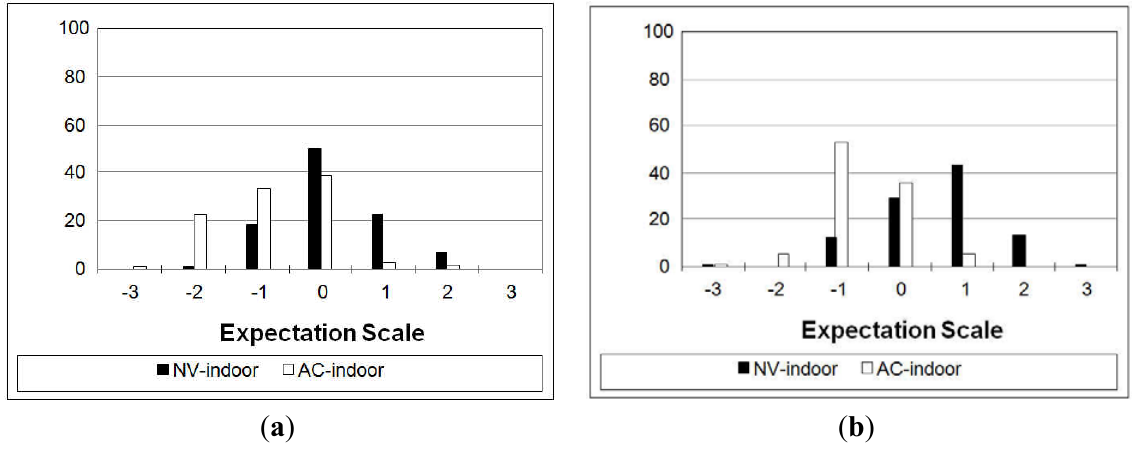
Figure 2. Relative frequency distribution (%) of thermal expectation votes in ( a ) the cool season; and ( b ) the warm season (NV = naturally ventilated; AC = air-conditioned).